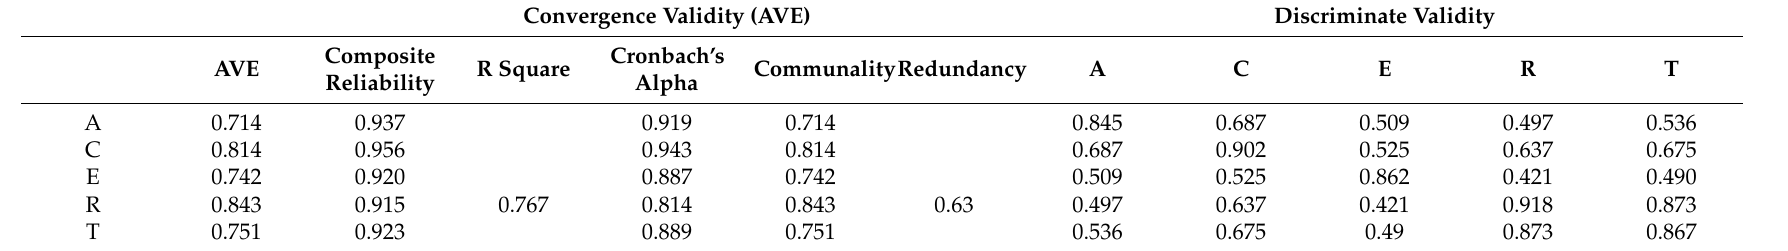
Table 6. Reliability and